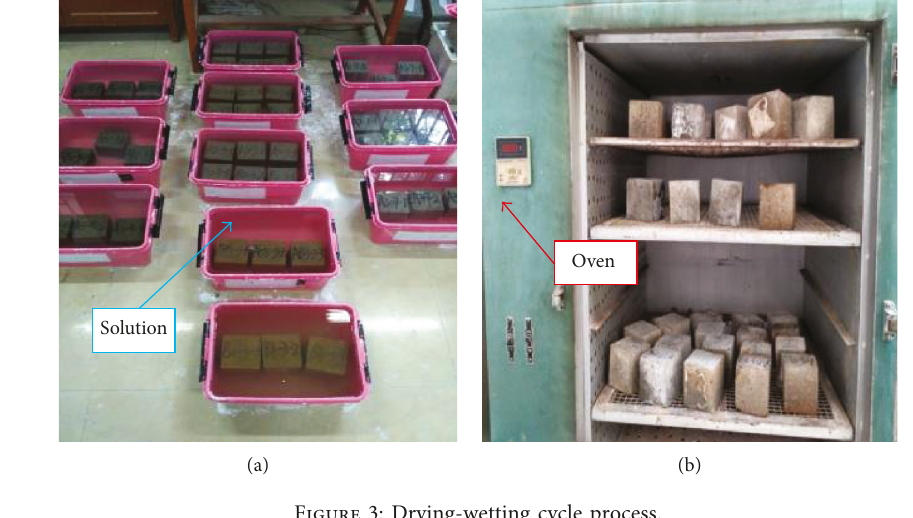
Figure 3: Drying-wetting cycle process.